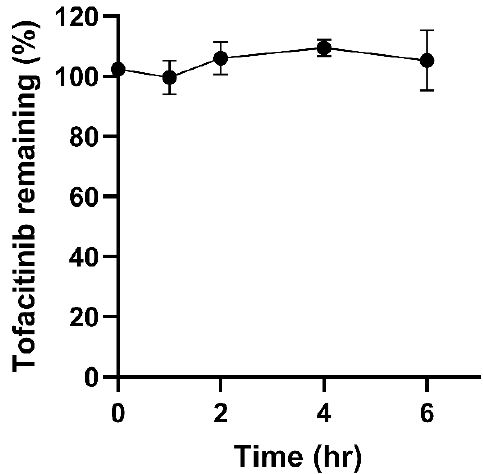
Figure 1. The stability of tofacitinib in rat caecal slurry over 6 h ( n =3).